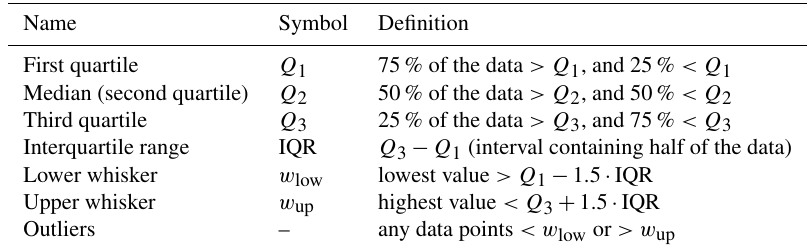
Table 1. Summary statistics used to visualize data spread throughout this study.